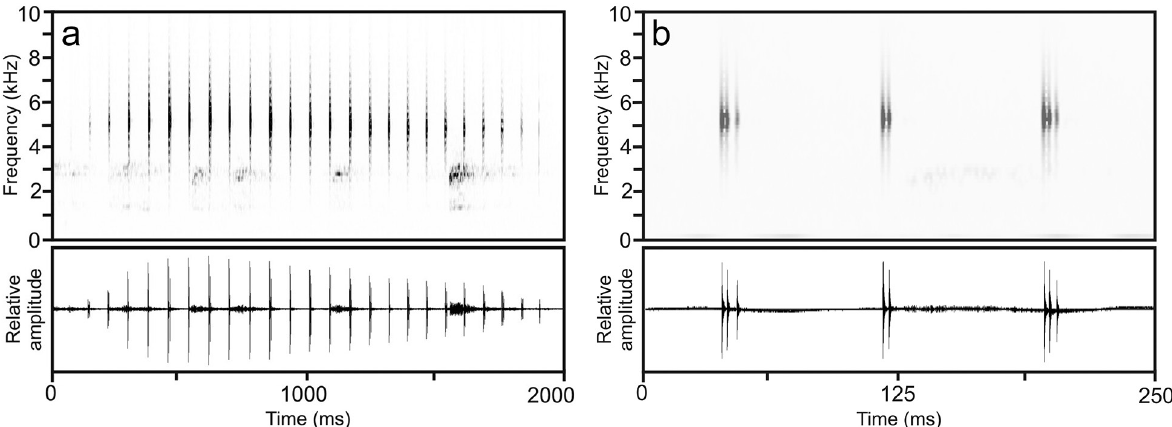
Figure 5. Spectrogram (above) and waveform (below) of a call of the holotype of Gephyromantis ( Vatomantis ) lomorina sp. n., ZSM 419/2016, from Marojejy. (a) A full call (spectrogram shown using FFT of 512 points to visualise call structure); and (b) a 250 ms section from the middle of a call, showing the degree of pulsation of each note (spectrogram shown using FFT of 128 points to visual- ise note